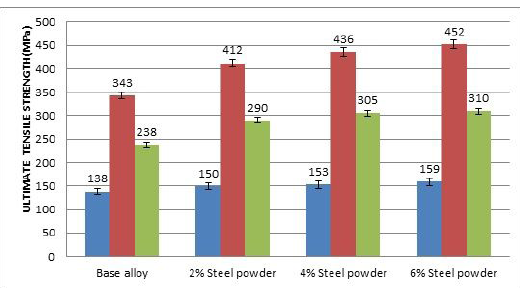
Figure 12. UTS of as cast and peak aged Al 7075 eutectoid steel reinforced composite- Bainite hybrid treatment.